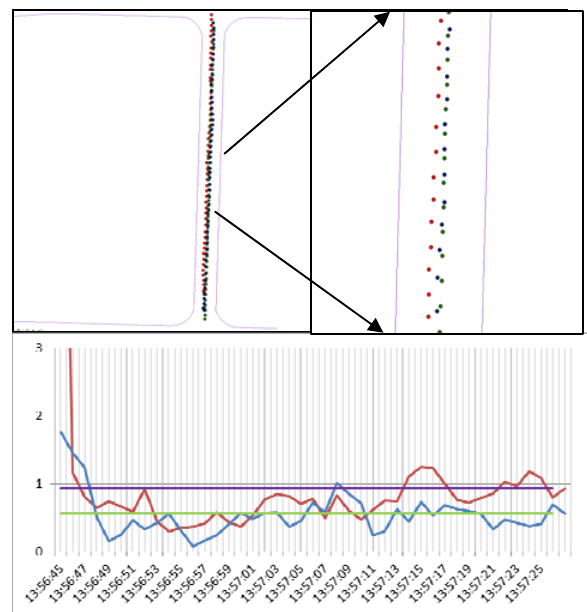
Figure 7. Comparre with GPS,QZS and VRS-GPS (Red: GPS, Blue: QZS1 L1-SAIF)